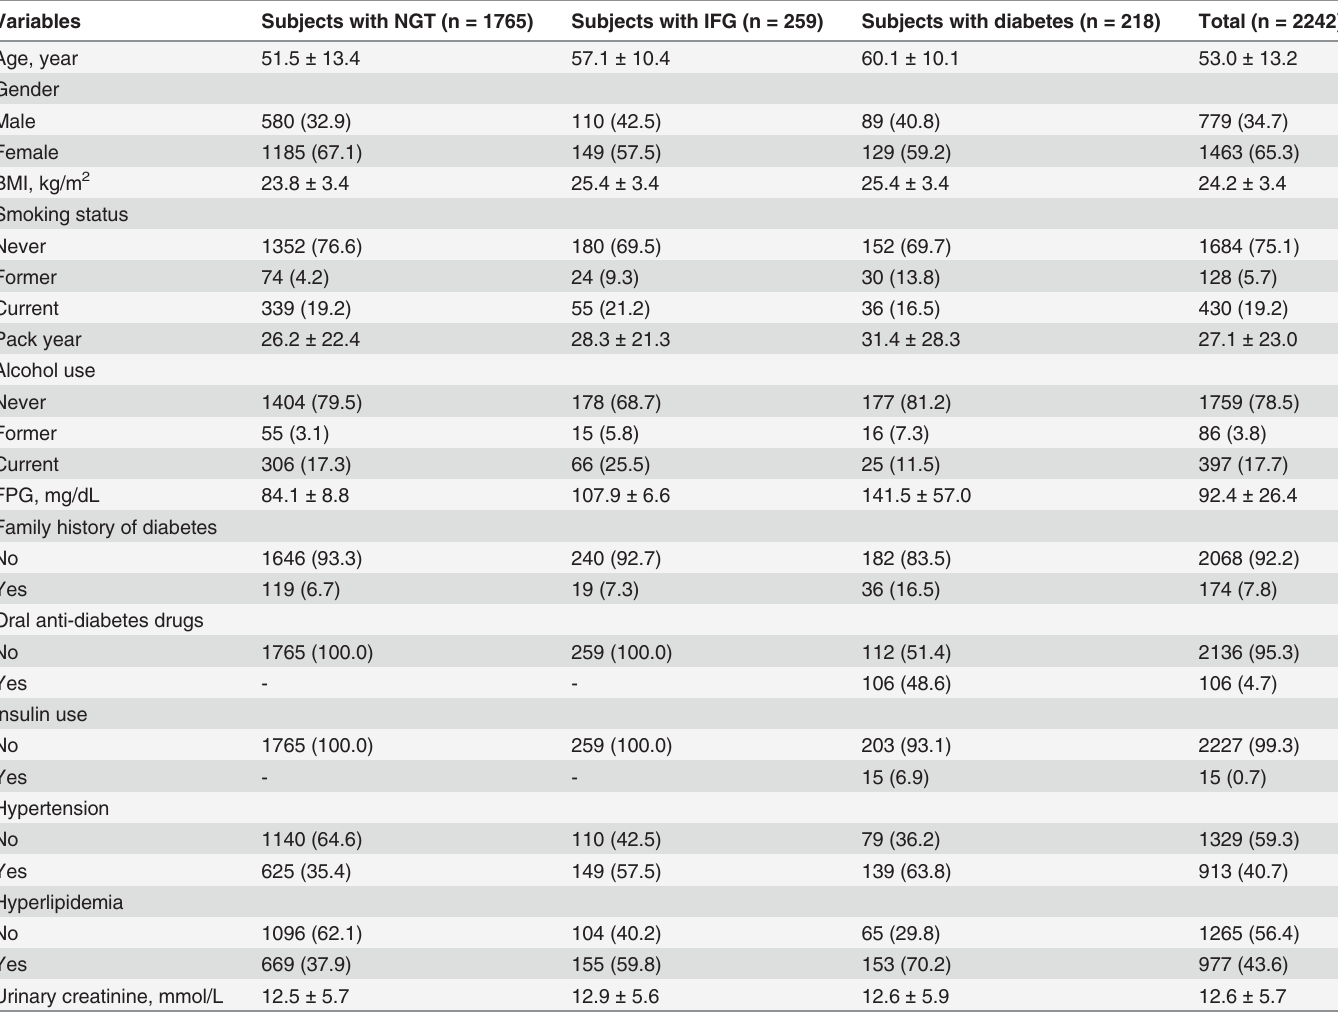
Table 1. Basic characteristics and clinical parameters of subjects in communities of Wuhan city,